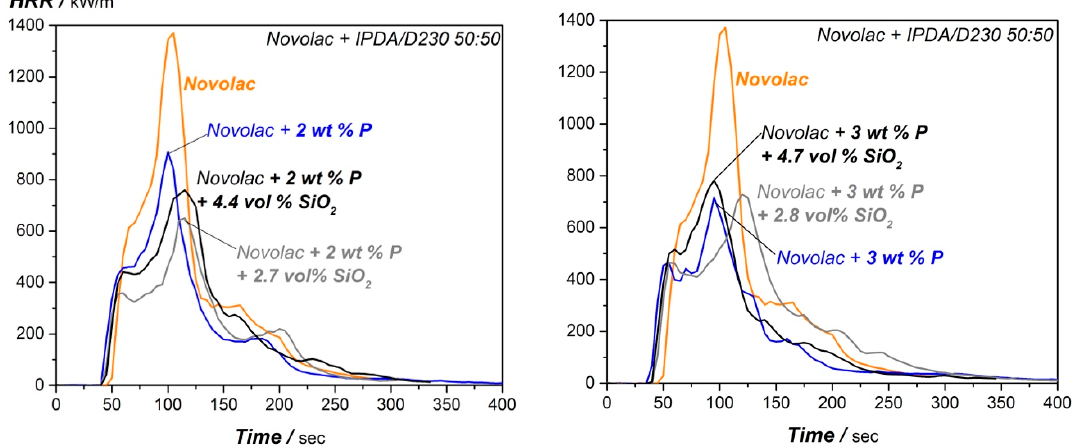
Figure 10. Cone calorimeter measurements for the modified epoxy novolac resin systems. Influence of silica content on 2 wt.% ( left ) and 3 wt.% ( right ) phosphorous modified resin. Table 7. Time to ignition (tti) and peak heat release rate (pHRR) from cone calorimeter experiments. Nano-SiO 2 Content /